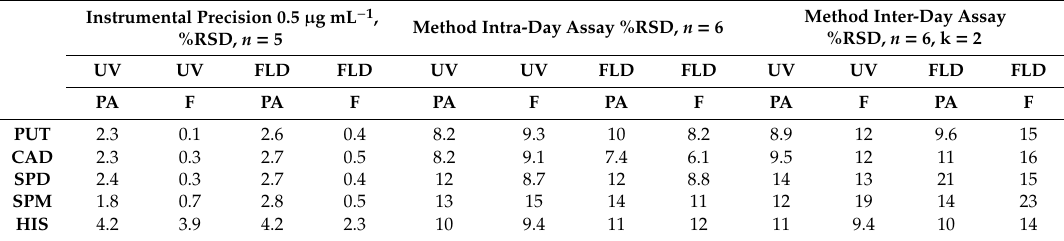
Table 6. Instrumental and method precision data under intra and inter day conditions with UV and FLD detectors, with analytical parameter the Peak Area (PA) and the ratio analyte peak area / internal standard peak area (F). BAs concentrations in tested sea bass sample for the method intra and inter-day assays: 2–10 mg kg − 1